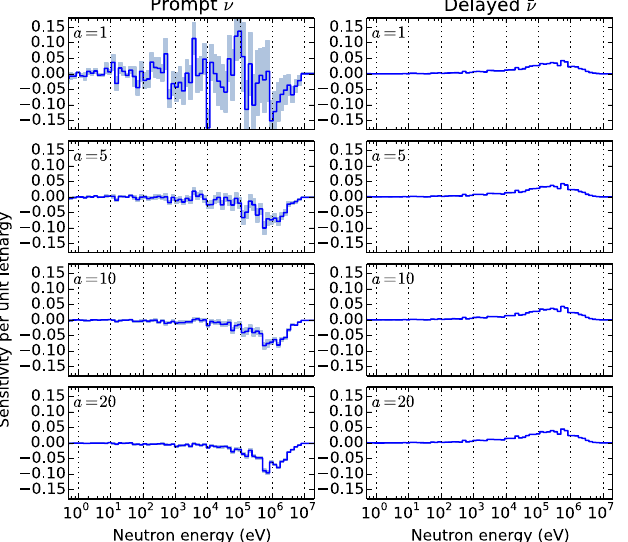
Fig. 5. Comparisons of b eff sensitivity pro fi le of 239 Pu n p (left) and n d (right) for the critical core with different scaling factors. The pale blue color around the blue line indicates 1 s statistical uncertainty.